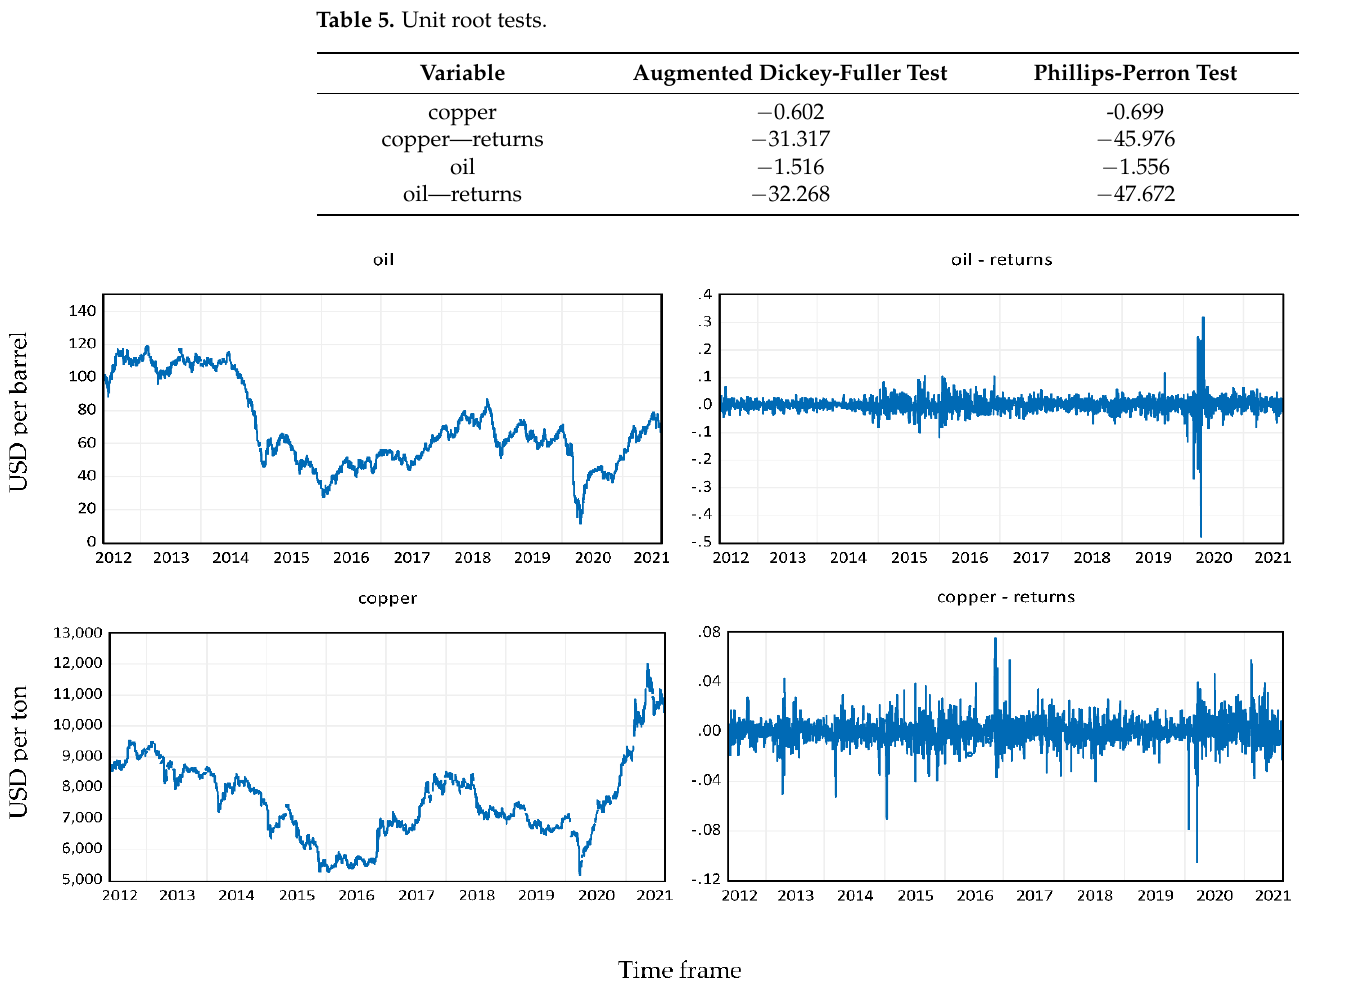
Figure 4. Time-series of crude oil and copper prices. Table 5. Unit root